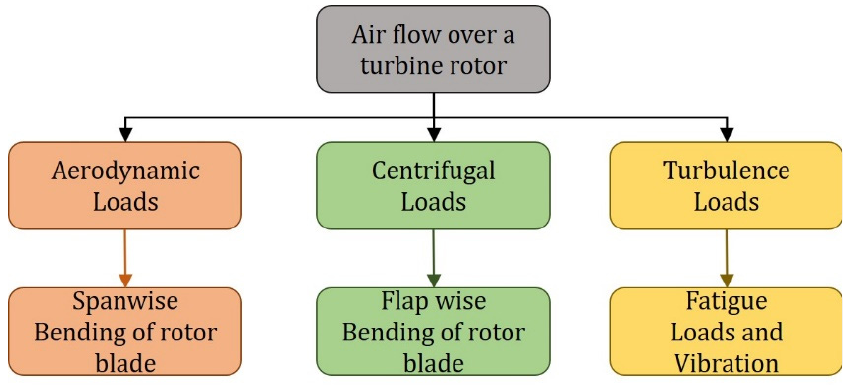
Figure 1. Importance of aerodynamic study.